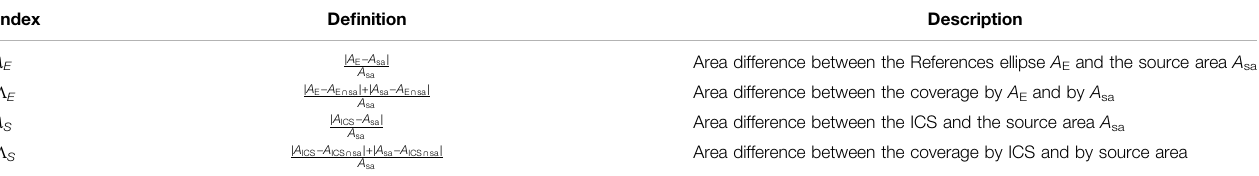
TABLE 2 | Indices for evaluating the performance of methods for constructing the ICS.